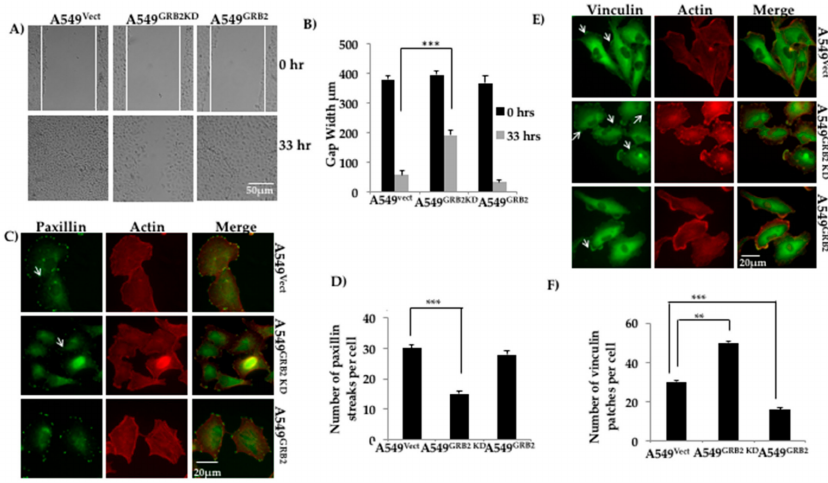
Figure 3. GRB2 promotes cell migration and reduced vinculin localisation in A549 cells. ( A ) A549 Vect , A549 GRB2KD and A549 GRB2 cells were seeded on a 6-well plate and grown to 100% confluency. A scratch was made on the monolayer and the cells were set for time lapse imaging in a chamber at 37 ◦ C with 5% CO 2 for a period of 48 h with live cell images being taken at 30 min intervals under a 10 × objective lens. The time point at which the gap of the control cells was taken as the reference time point (33 h). Images from the 0 h and 33 h time points were considered for calculations; ( B ) Gap width was measured using Image J software. A total of 6 random fields per time point per sample were measured for each experiment. Three independent experiments were performed to calculate the significance